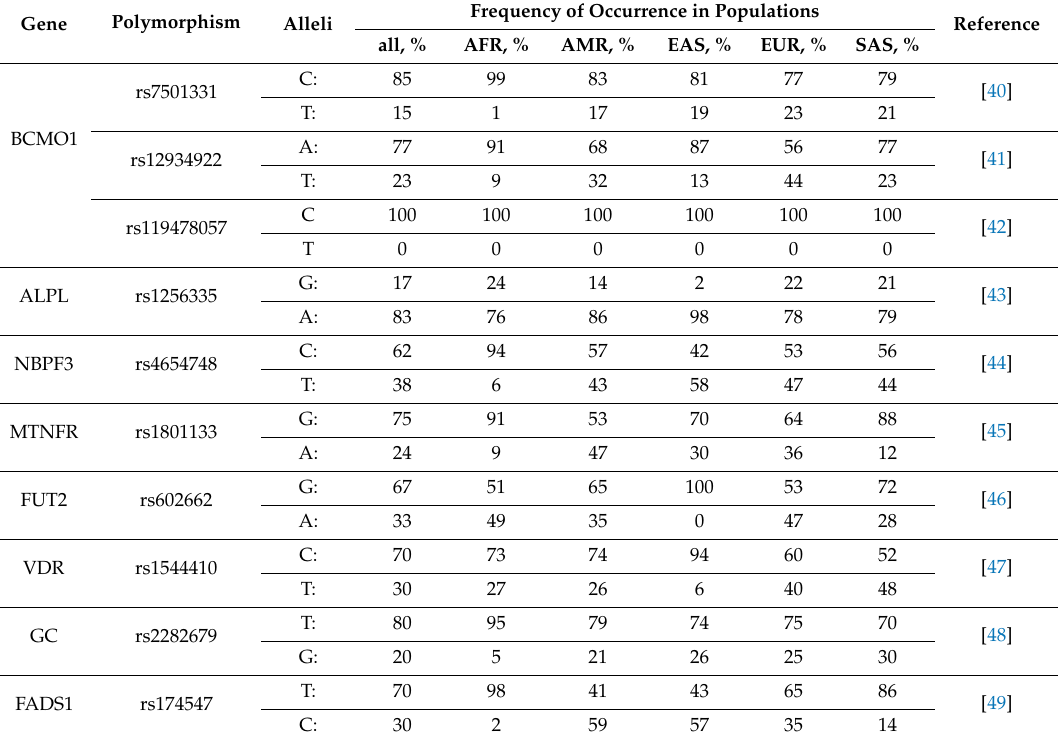
Table 3. Population genetics of genes responsible for vitamin metabolism.